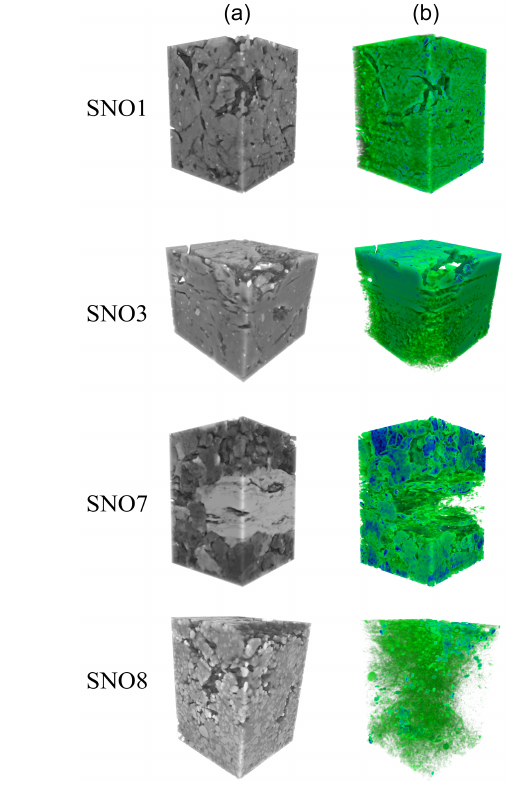
Figure 7. Cuboids with horizontal edge lengths of 14.4mm ex- tracted from the centre of SNO1 (height 17.76mm), SNO3 (height 14.8mm), SNO7 (height 20.32mm) and SNO8 (height 20mm). The reference images (a) and the respective Ba 2 + distributions (b) are shown. Dark grey values depict low density and bright grey values depict high-density regions. The Ba 2 + distribution is visualized by translucent (no or little Ba 2 + ), green (medium Ba 2 + density) and blue (high Ba 2 + density) colours. Note that the colour scales are optimized for depicting the 3-D structures. They are therefore only semi-quantitative.